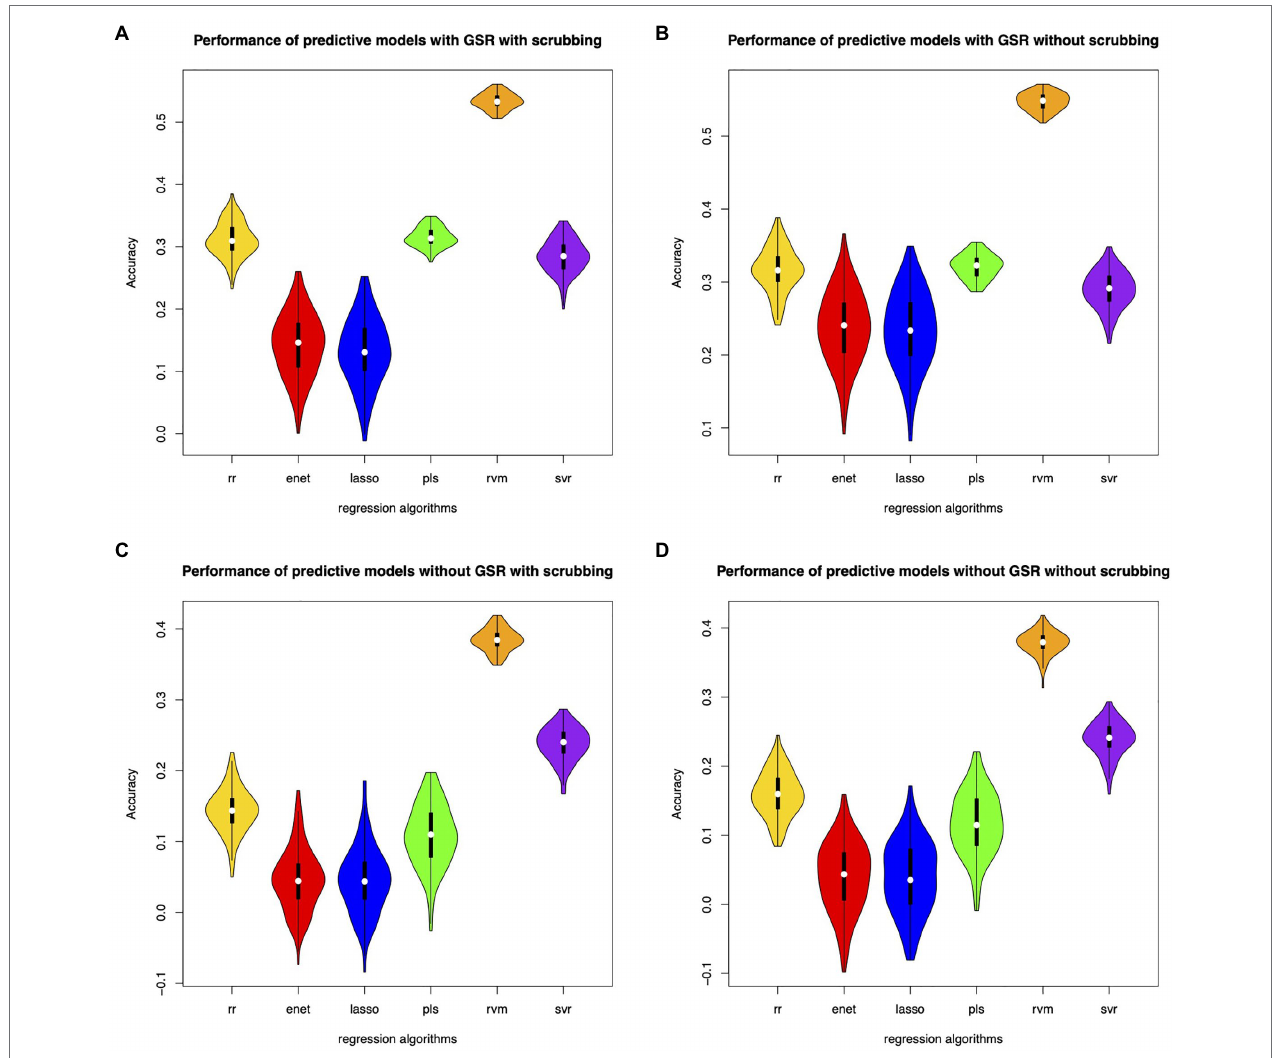
FIGURE 6 | Performance of the predictive models with the mRMR feature selection. (A) denotes performance of the predictive models with GSR and scrubbing. (B) denotes performance of the predictive models with GSR and without scrubbing. (C) denotes performance of the predictive models without GSR and with scrubbing. (D) denotes performance of the predictive models without GSR and scrubbing.